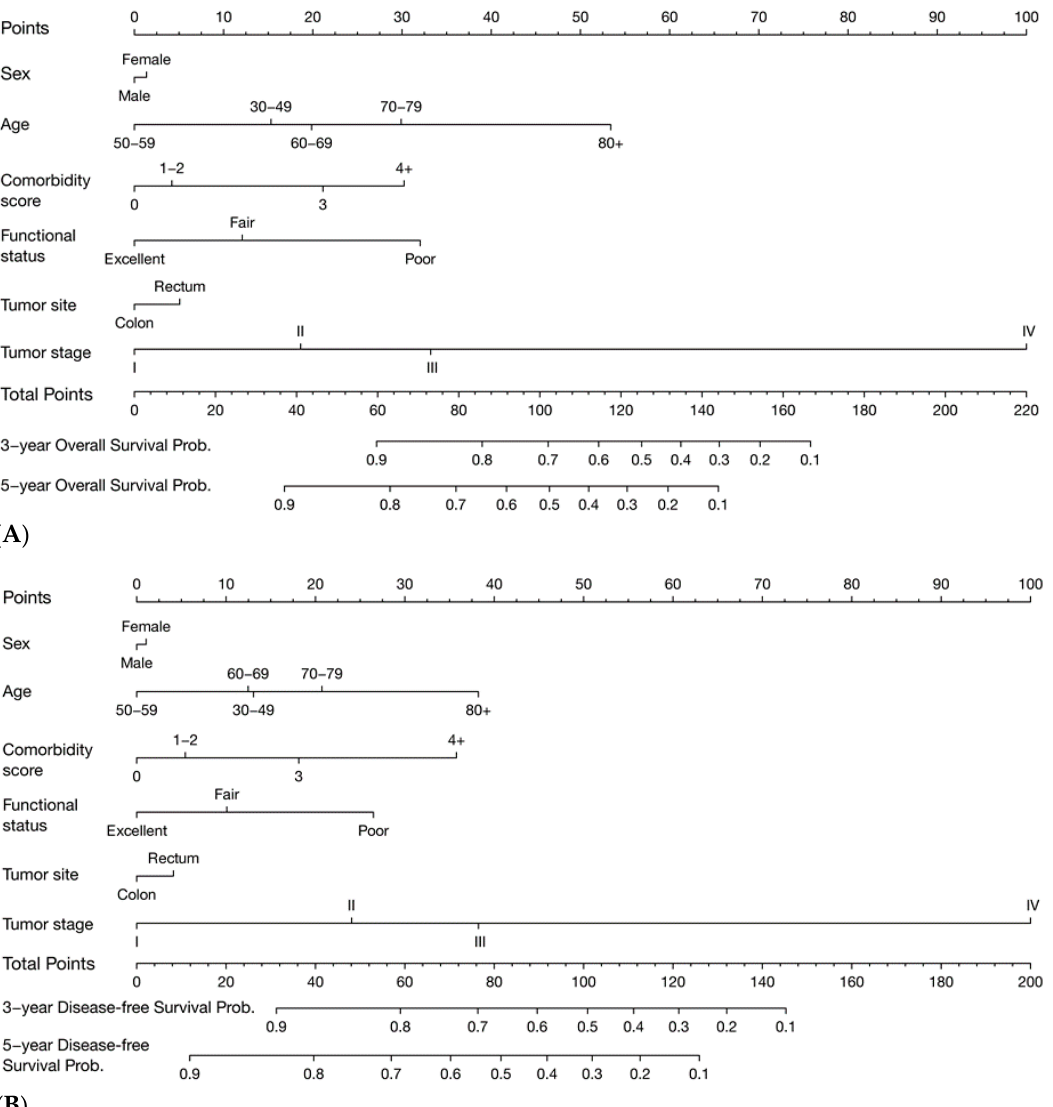
Figure 1. Nomograms for predicting three- and five-year overall and disease-free survival. Nomograms for ( A ) overall survival and ( B ) disease-free survival; Prob, probability. Total points were obtained by summing up individual points from the respective variables; higher points indicate poorer survival. Three- and five-year survival probabilities are then predicted using the total nomogram points.